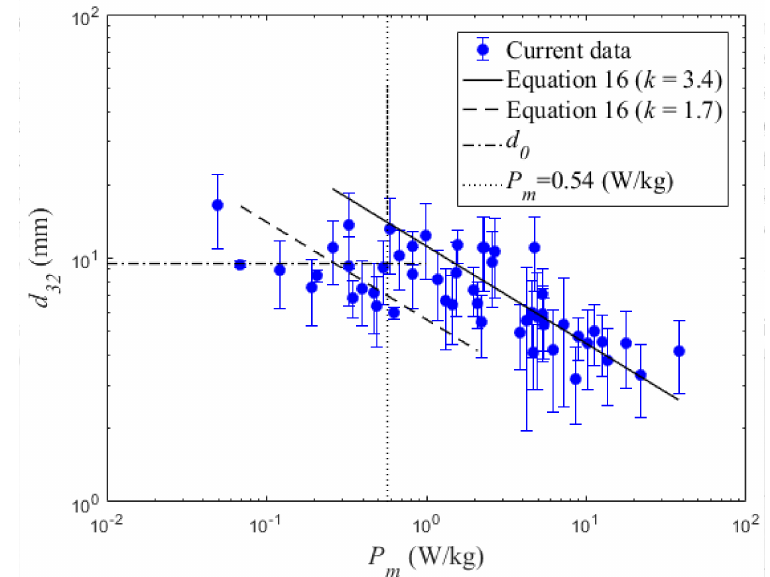
Figure 8. The bubble Sauter mean diameter ( d 32 ) plotted versus the input power, Equation (17). These results are compared against Hinze based correlations for the maximum stable bubble size as well as the static bubble column Sauter mean diameter ( d 0